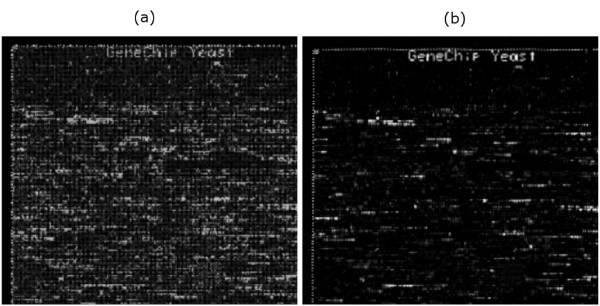
Example of an Affymetrix microarray simulation. Example of the simulated single-channel oligonucleotide microarray slide image (crop from top left corner) (a). We have used an Affymetrix .cel file as the ground truth data. Thus the text about the slide type is observable. Real Affymetrix slide image is shown for comparison (b).